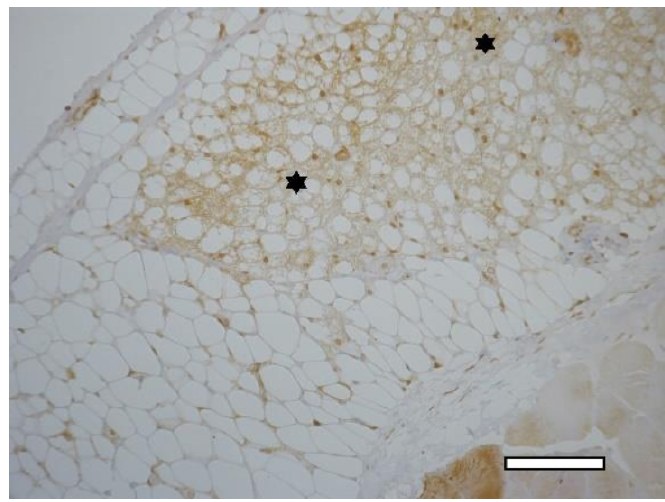
Figure 13. 1st group (dECM only), 2 weeks. Staining of white and brown (asterisk) adipose tissue for nuclear antigen of proliferating cells, objective lens × 20, scale bar—100 µ m.